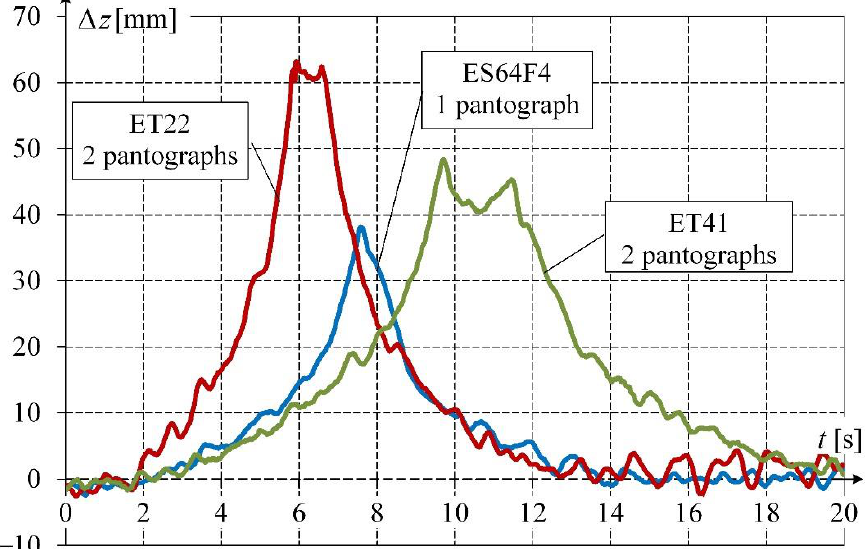
Figure 3. Selected waveforms of contact wire uplift ∆ z ( t ) measured at OCL suspension point for different numbers of lifted pantographs of single-unit (ES64F4) and articulated locomotives (ET22, ET41); source: own elaboration by the authors of this article.